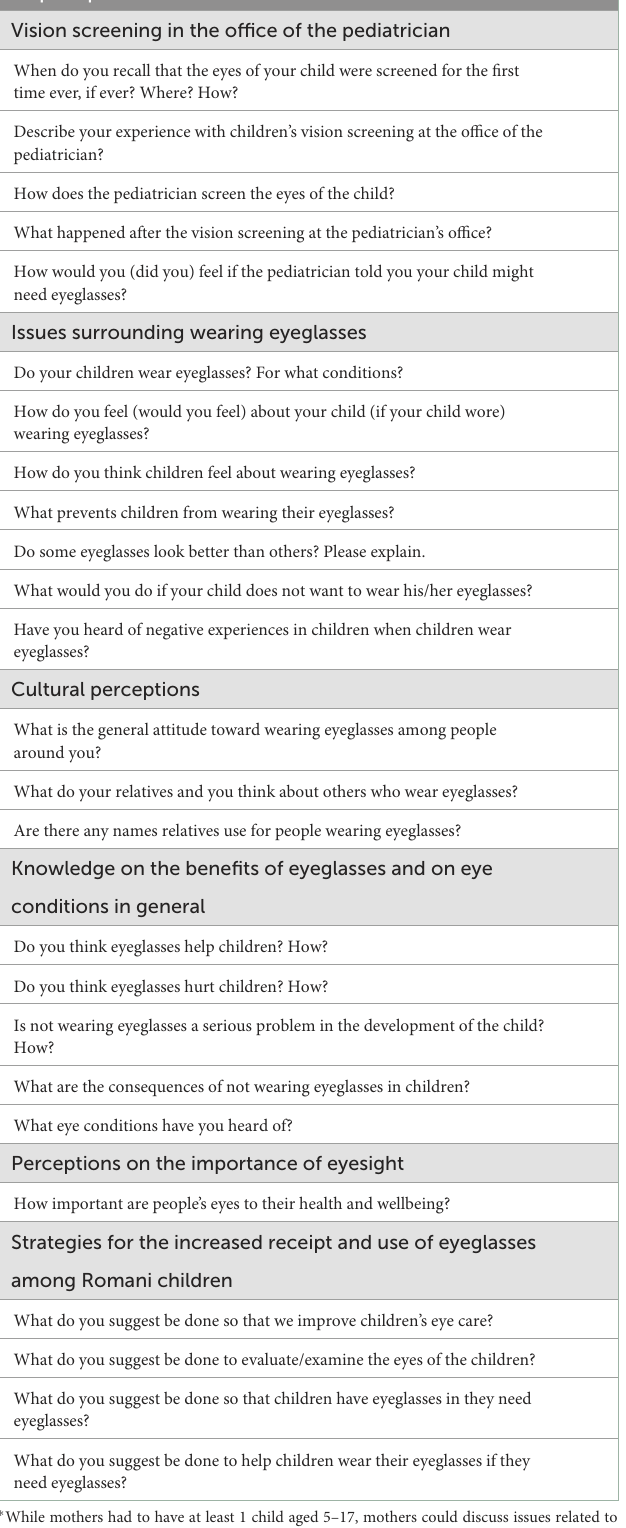
TABLE 1 Focus group guide questions ∗ asked during step 1 of the study.